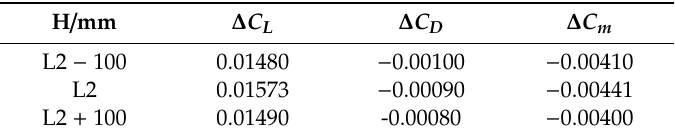
Figure 11. Support interference results of the BWB aircraft with di ff erent first-section lengths (H = L2 − 100 mm / L2 / L2 + 100 mm, Ma = 0.75): ( a ) C L - α curves; ( b ) C D - α curves; ( c ) C m - α curves. Table 8. Interference results of the BWB aircraft with di ff erent first-section lengths (H = L2 − 100 mm / L2 / L2 + 100 mm, Ma = 0.75, α = 0 ◦